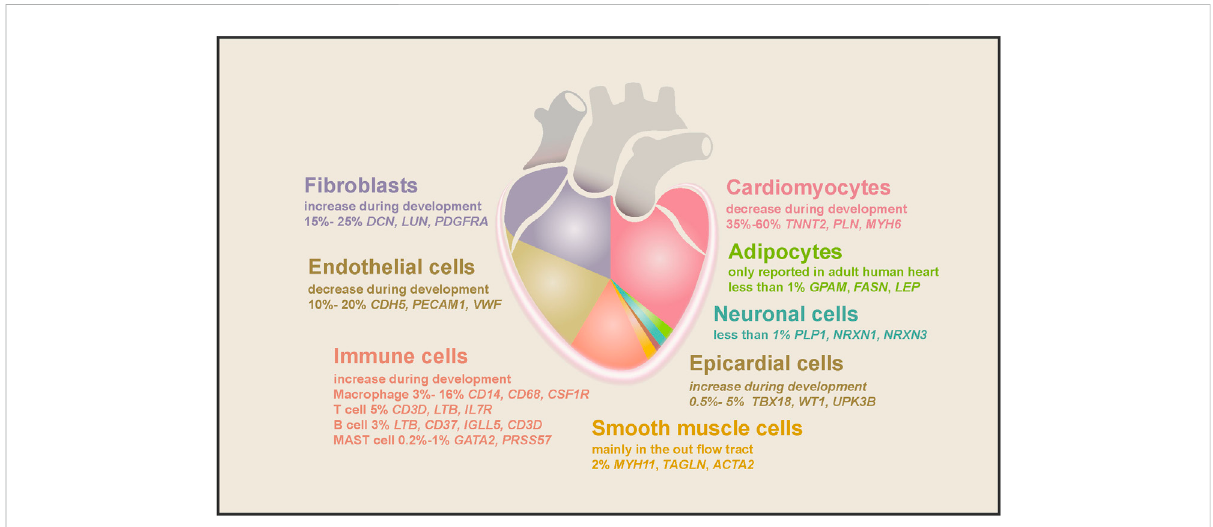
FIGURE 2 The cell types found in the human heart and their marker genes. Cell types and their proportion range in embryonic and adult hearts are depicted in different colors. As the largest population in the human heart, cardiomyocytes comprise half of the total cells, decreasing during embryonic heart development. The second-largestcell populationis fi broblasts, increasingduring heart developmentand aging. ECsaccountedfor 10% – 20% of cardiac cells, and their proportion decreased gradually as the heart matured. Macrophages are the largest cardiac immune cell population, making up half of the total immune cells. SMCs, epicardial cells, and neuronal cells consist of 2%, 0.5% – 5%, and less than 1% of cell populations in the heart, while adipocytes were only found in the adult heart.